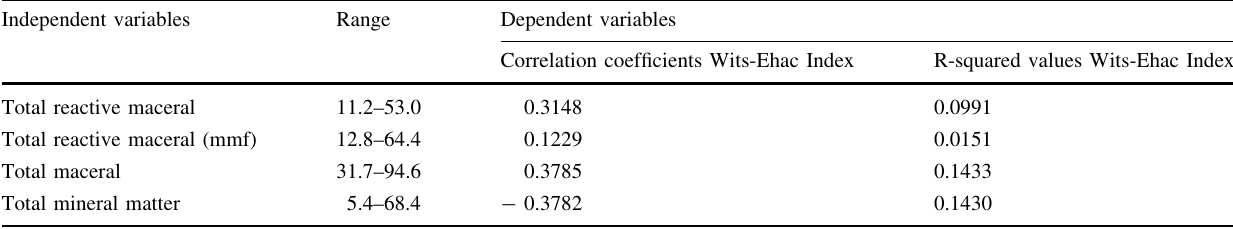
Table 4 Relationships between independent (total reactive maceral, total maceral and total mineral matter-vol%) and dependent variables for the coal